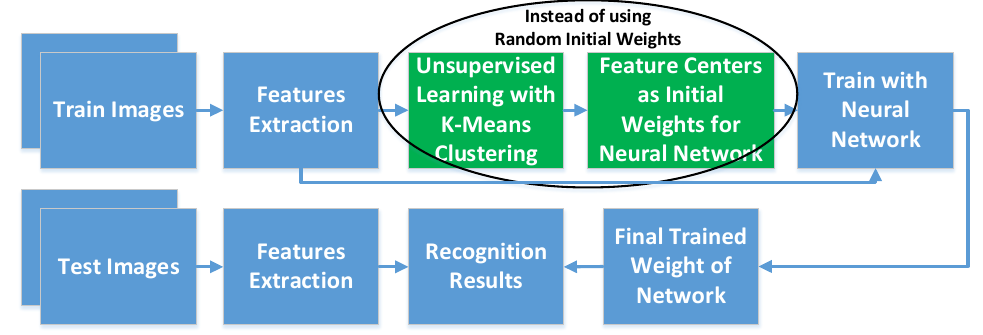
Figure 9. Schema of character recognizer with feature extraction method, unsupervised learning feature, and neural network [29].